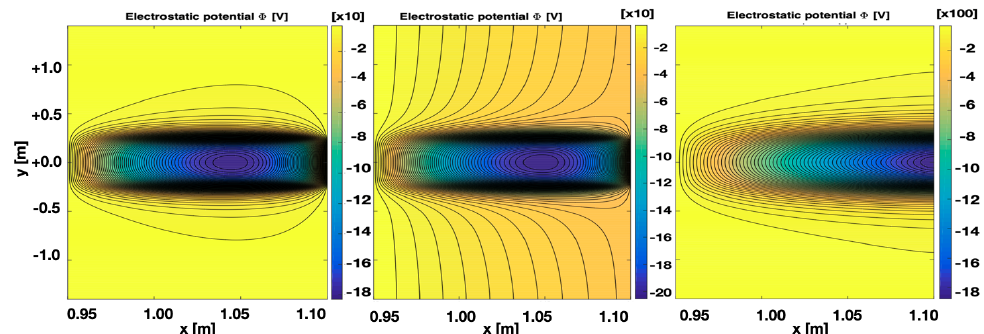
Figure 6. Electrostatic potential consistent with a local charge neutrality imbalance near the antenna of 10 14 /m 3 : Φ antenna = 0 ( left ), Φ antenna = − 35 V ( middle ), and ∂ Φ antenna / ∂ x = 0 ( right ). See text for